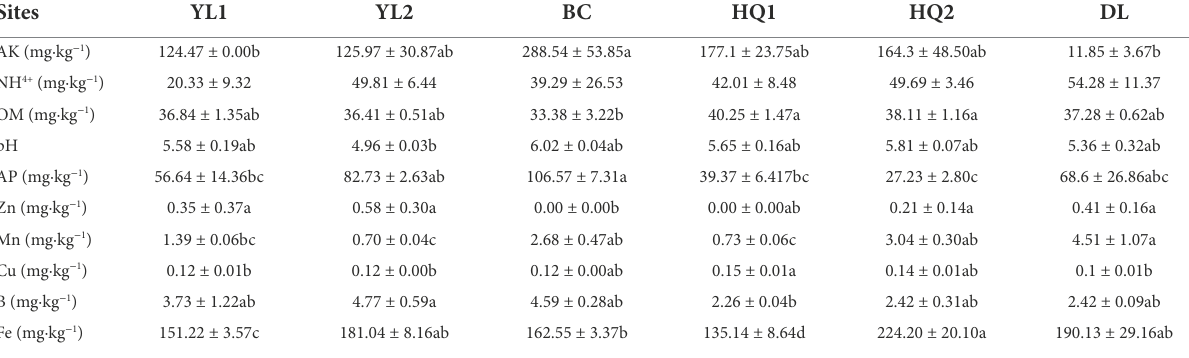
TABLE 2 Soil physicochemical properties in different sample sites (means ± standard errors). Sites